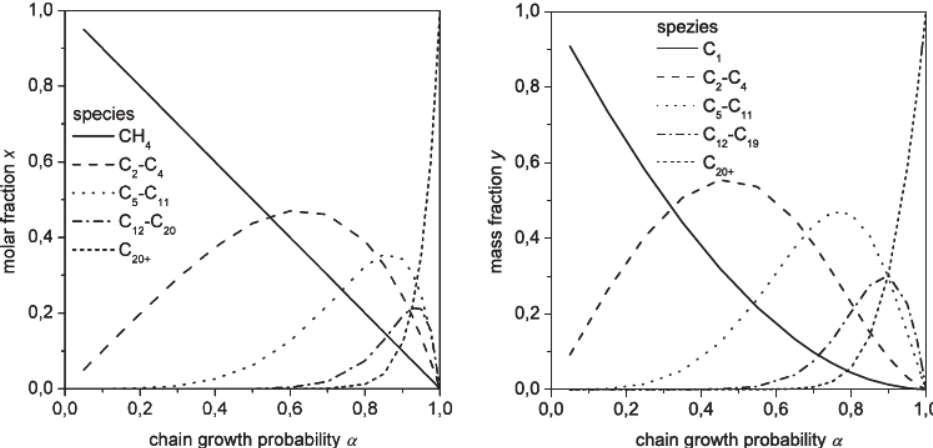
Figure 6. FT product distribution as a function of chain growth probability